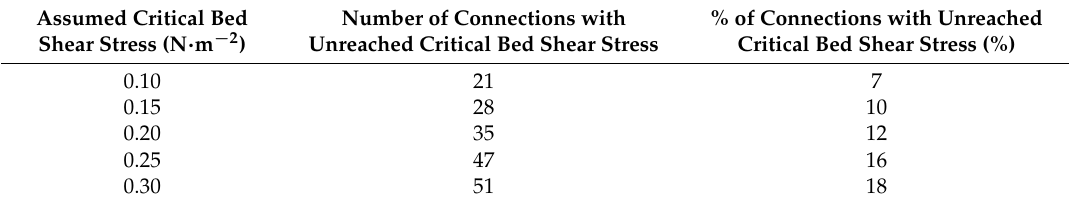
Table 8. Number and percent of conduits that did not reach assumed bed shear stress on the basis of simulation in the SWMM 5.1